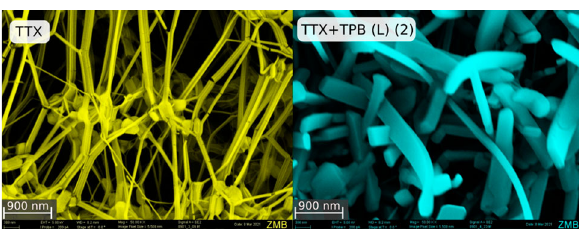
Fig. 16 Close (300nm scale bar) SEM images of TTX and TTX+TPB (L) (2). The images were colored in yellow and blue, respectively, to ease the observation of their structures